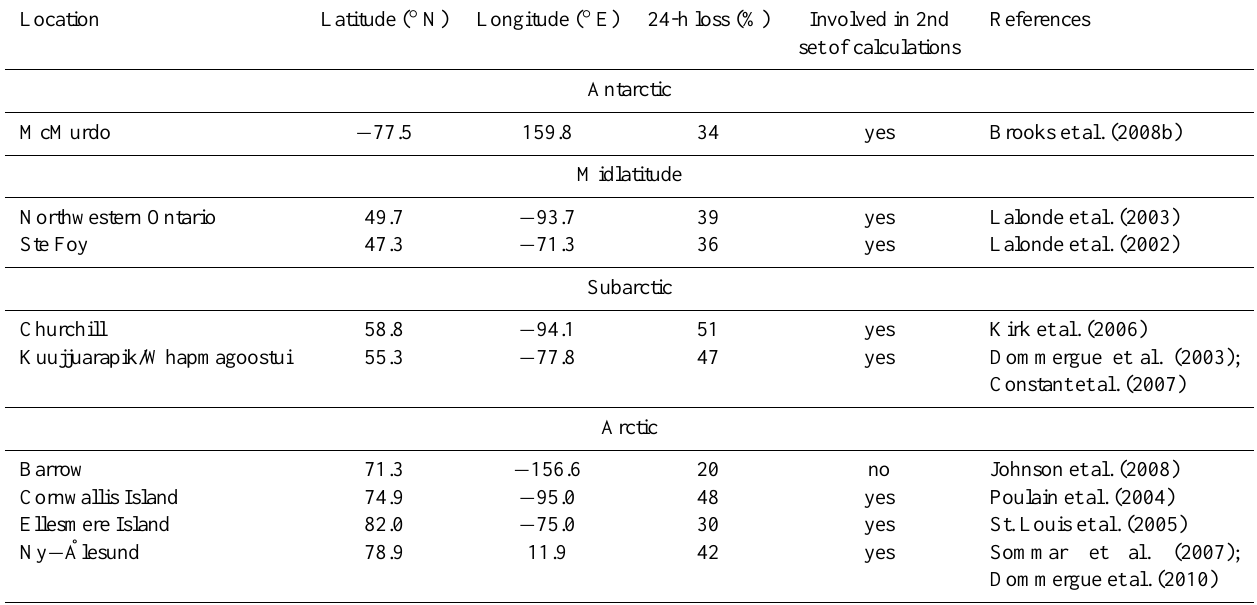
Table 1. Mean 24-h losses of total mercury from surface